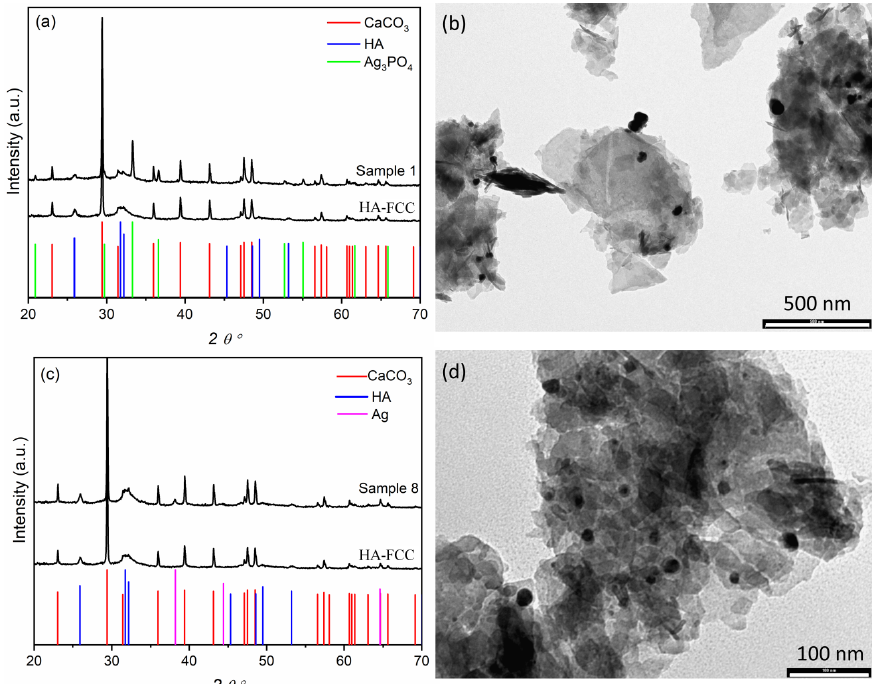
Figure 2. XRD pattern of HA-FCC compared with the samples 1 ( a ) and 8 ( c ). Below the spectra are reported the pattern lines of: CaCO 3 (PDF#01-083-1762)—red lines, HA (PDF#01-086-0740)—blue lines, Ag 3 PO 4 (PDF#01-084-0192)—green lines, Ag (PDF#87-597)—magenta lines. TEM images of the samples 1 ( b ) and 8 ( d ).